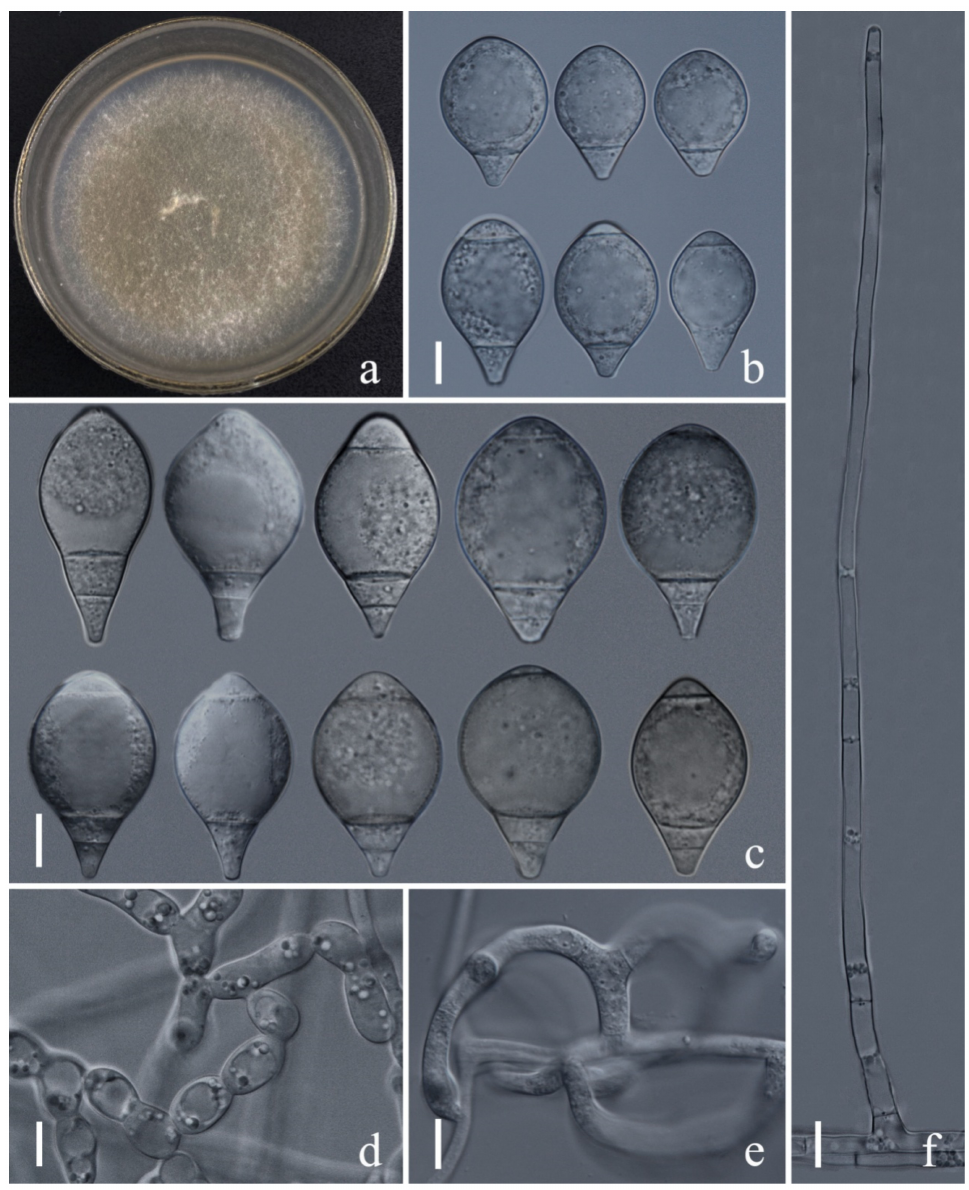
Figure 7. Arthrobotrys zhaoyangensis (CGMCC3.20944). ( a ) Colony. ( b , c ) Conidia. ( d ) Chlamydospore. ( e ) Trapping device: adhesive network. ( f ) Conidiophores. Scale bars: ( a ) = 1 cm, ( b – f ) = 10 µ